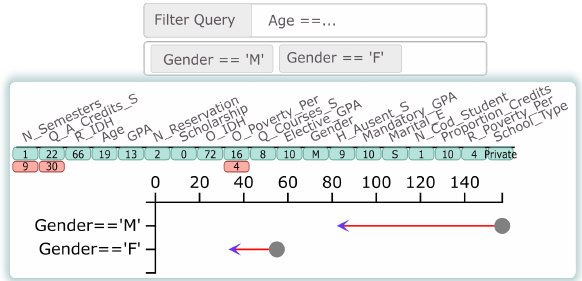
Figure 6. The impact view shows the impact of a counterfactual on two groups. For example, for male (M) students, the counterfactual reduces the dropout from 150 to 80 students (avoiding 70 dropouts), while for female students, around 20 dropouts are